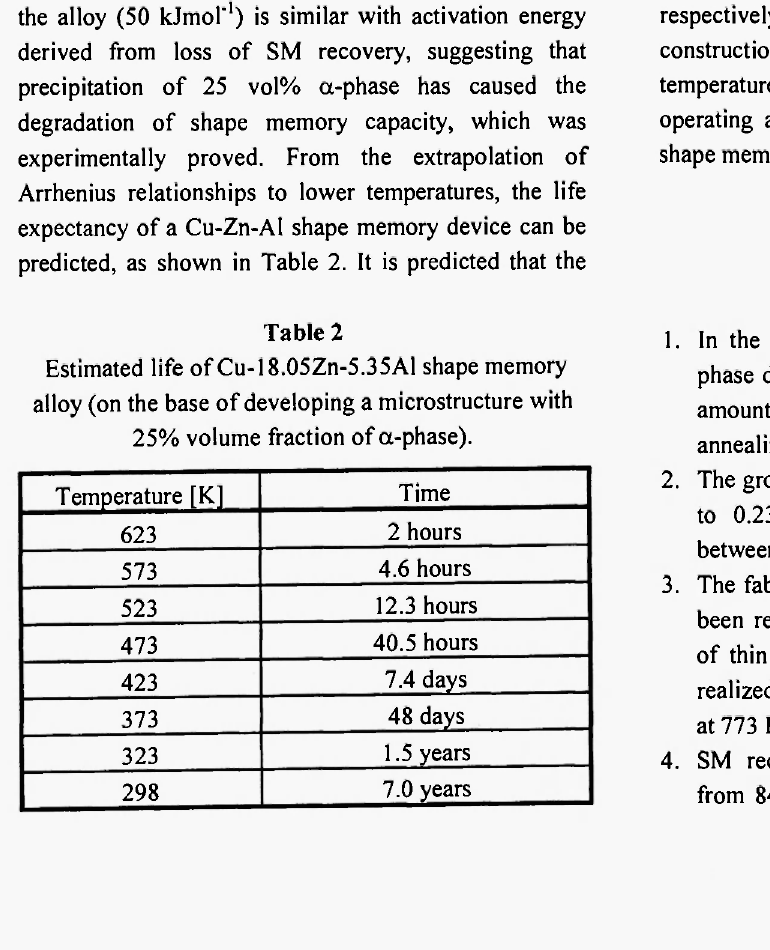
defects inevitably generated by transformation of martensite to parent phase during heating 121.